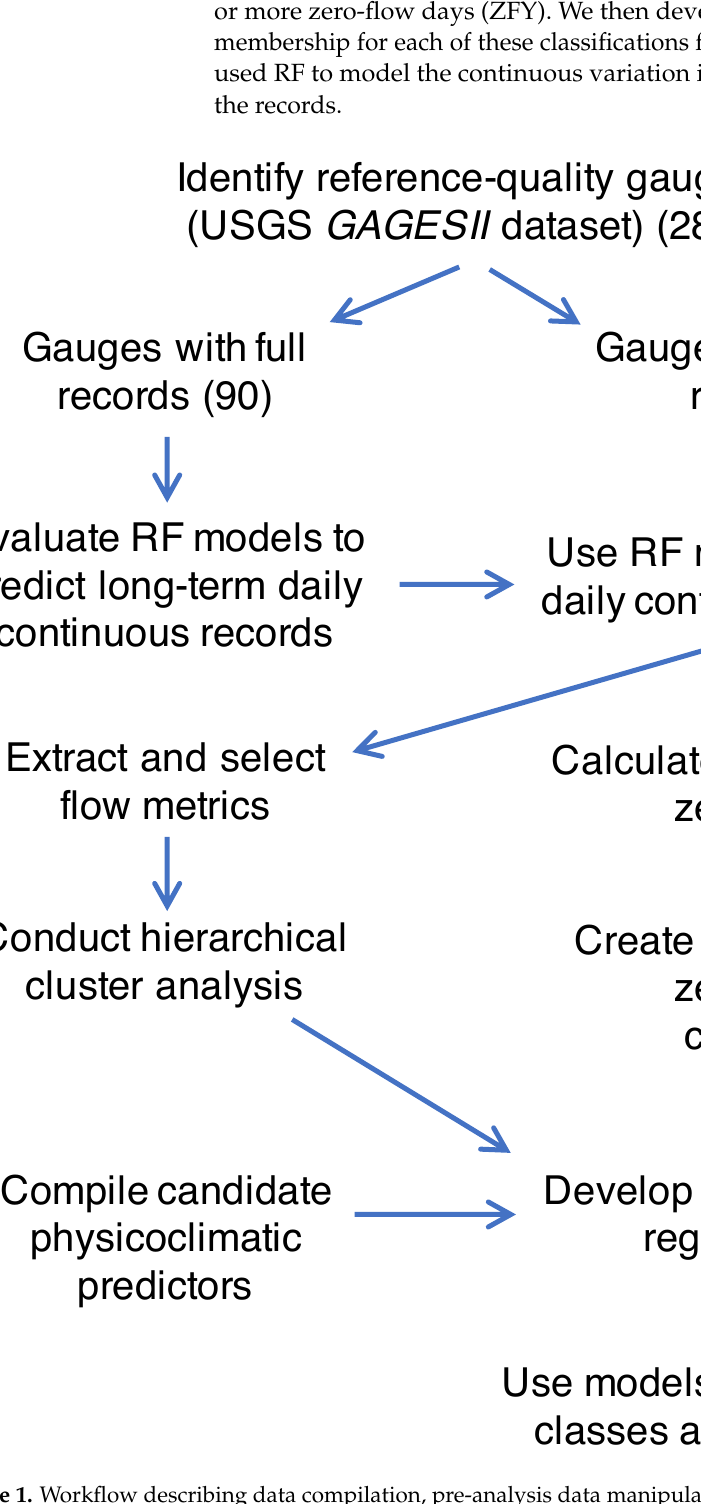
Figure 1. Workflow describing data compilation, pre-analysis data manipulation, classification, modeling, and